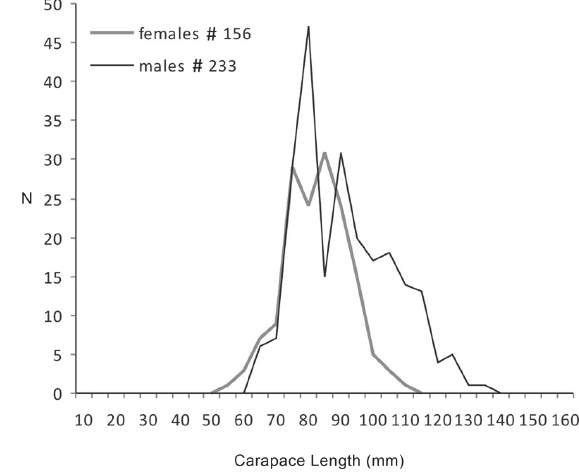
Fig . 1. – size distribution (Cl, mm) of tag-recaptured lobsters in the protected area and its surrounding zone.